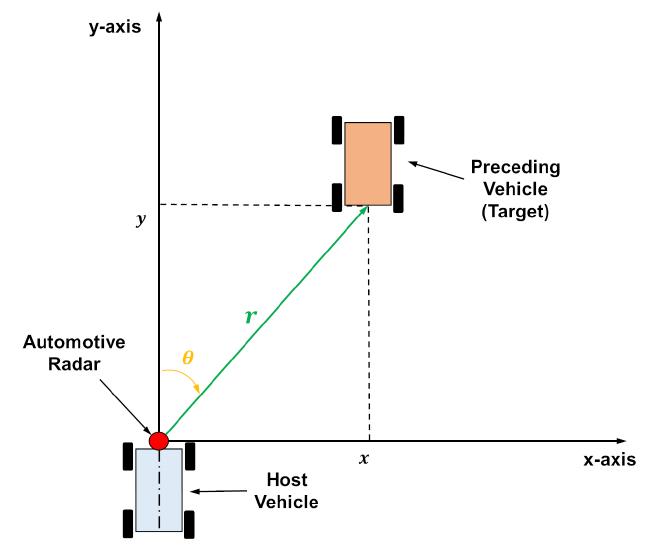
Figure 1. Automotive radar